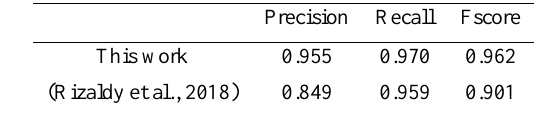
Table 3. Model 1 results. Our PointNet results improve upon